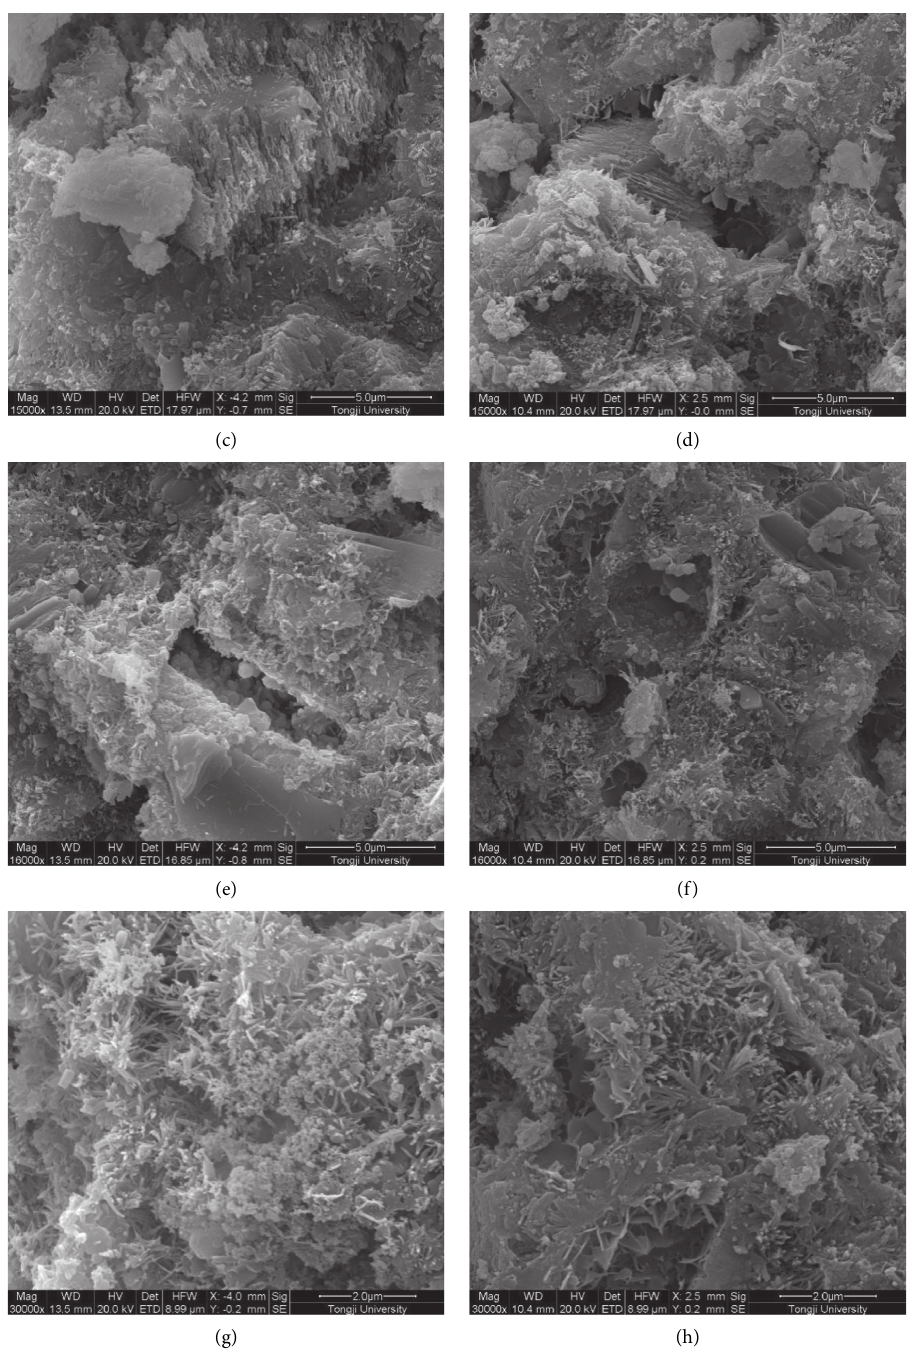
Figure 5: The fracture morphology of inner part and outer part of specimens: (a) inner part; (b) outer part; (c) inner part; (d) outer part; (e) inner part; (f) outer part; (g) inner part; (h) outer